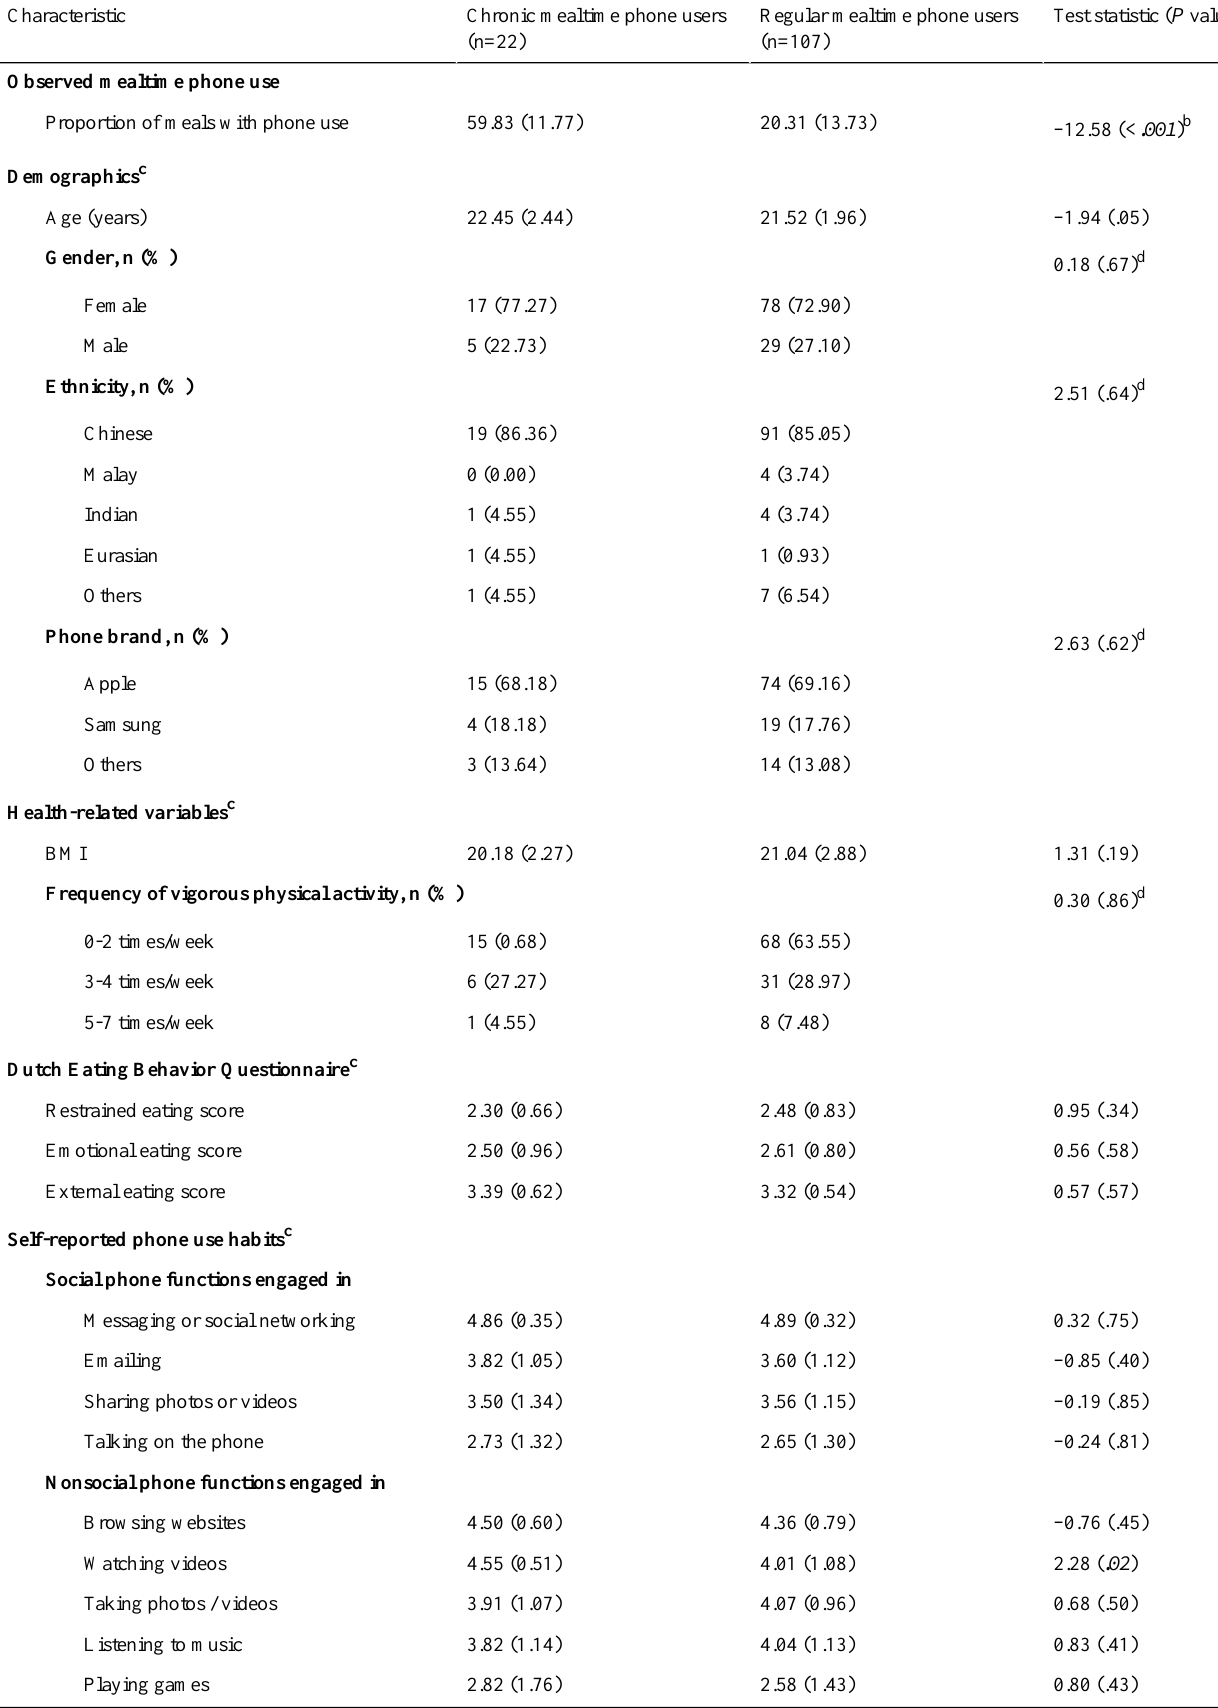
Table 1. Participant characteristics as a function of mealtime phone use patterns a